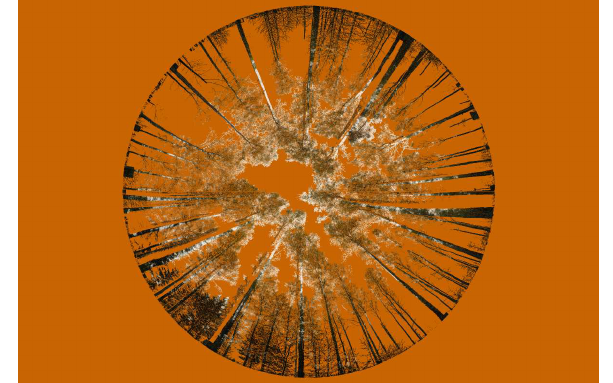
Figure 5: 2D representation of the colorized point